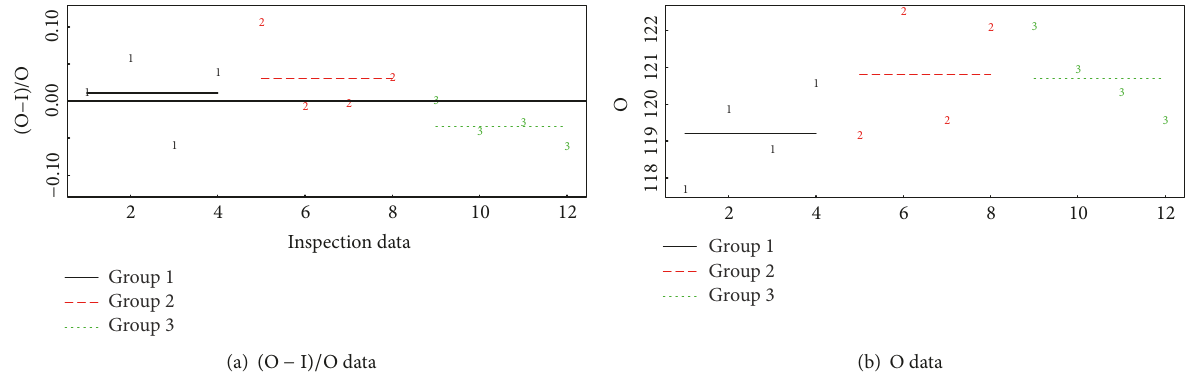
Figure 2: Example of real (a) ( O - I )/ O and (b) O for data from 3 groups, 4 measurements per group.